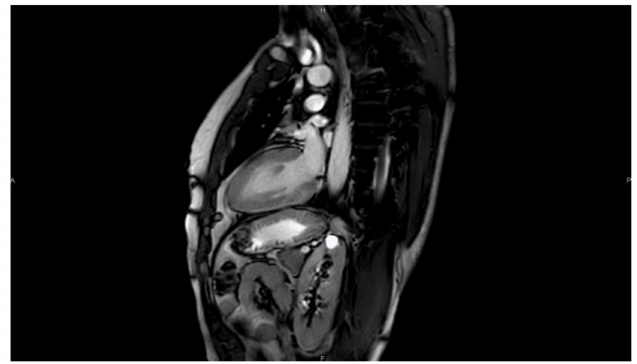
Figure 10. CMR image 2CH